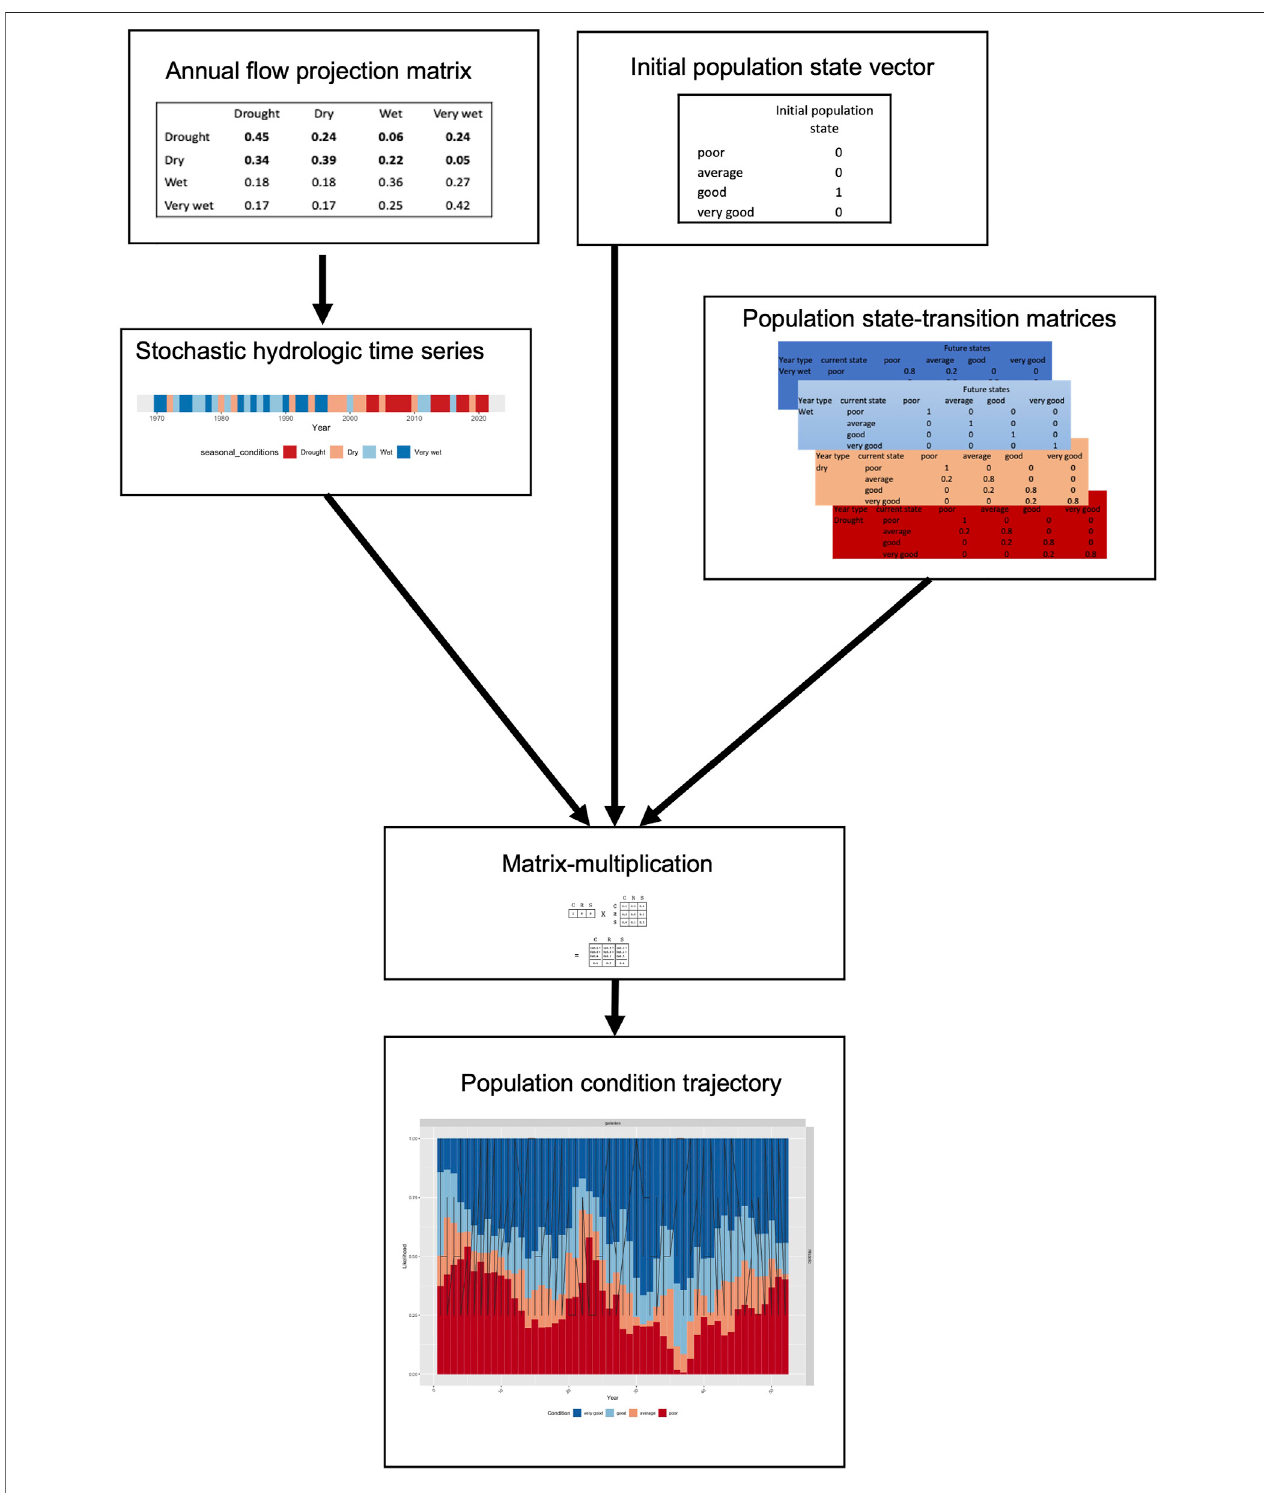
FIGURE 1 | Diagram showing the Inputs and sequence of steps involving in generating the population projections using the STSM approach.